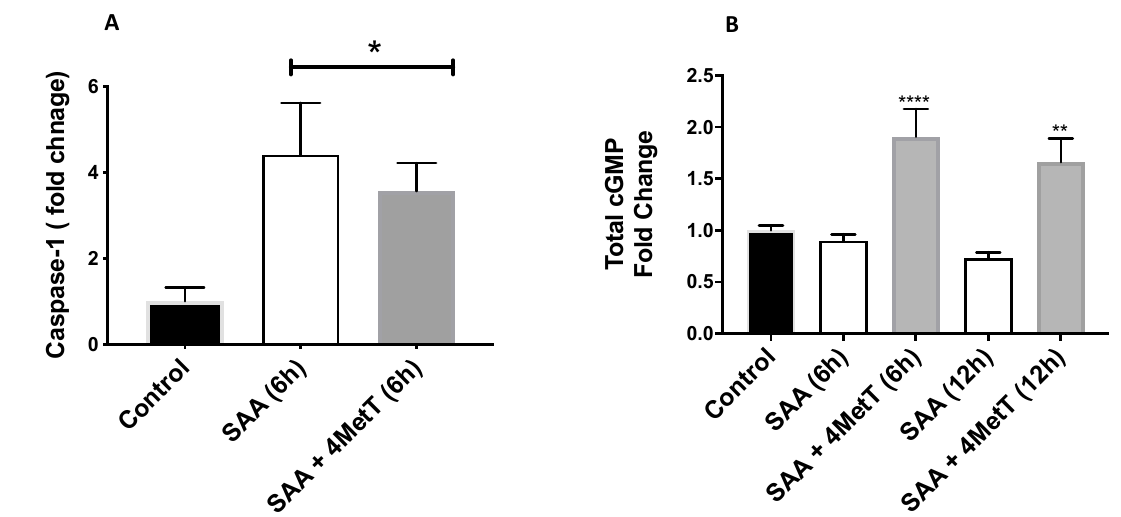
Figure 5. Caspase-1 levels in HAEC in response to SAA and 4-MetT. ( A ). Cells were treated with 10 µ g/mL SAA at either 6 h and with or without 25 µ M 4-MetT pretreatment for 24 h, or DMSO (vehicle control). Data represent mean ± SD, n = 7 control, SAA; n = 3 SAA + 4-MetT, independent biological replicates. * Different to control in the absence of SAA, p < 0.005 ( B ). Total cGMP levels in HAEC total cell protein lysates in response to added SAA and 4-MetT. * Different to control in the absence of SAA, * p < 0.05; ** p < 0.001; **** p < 0.0001Different to SAA-treatment group.